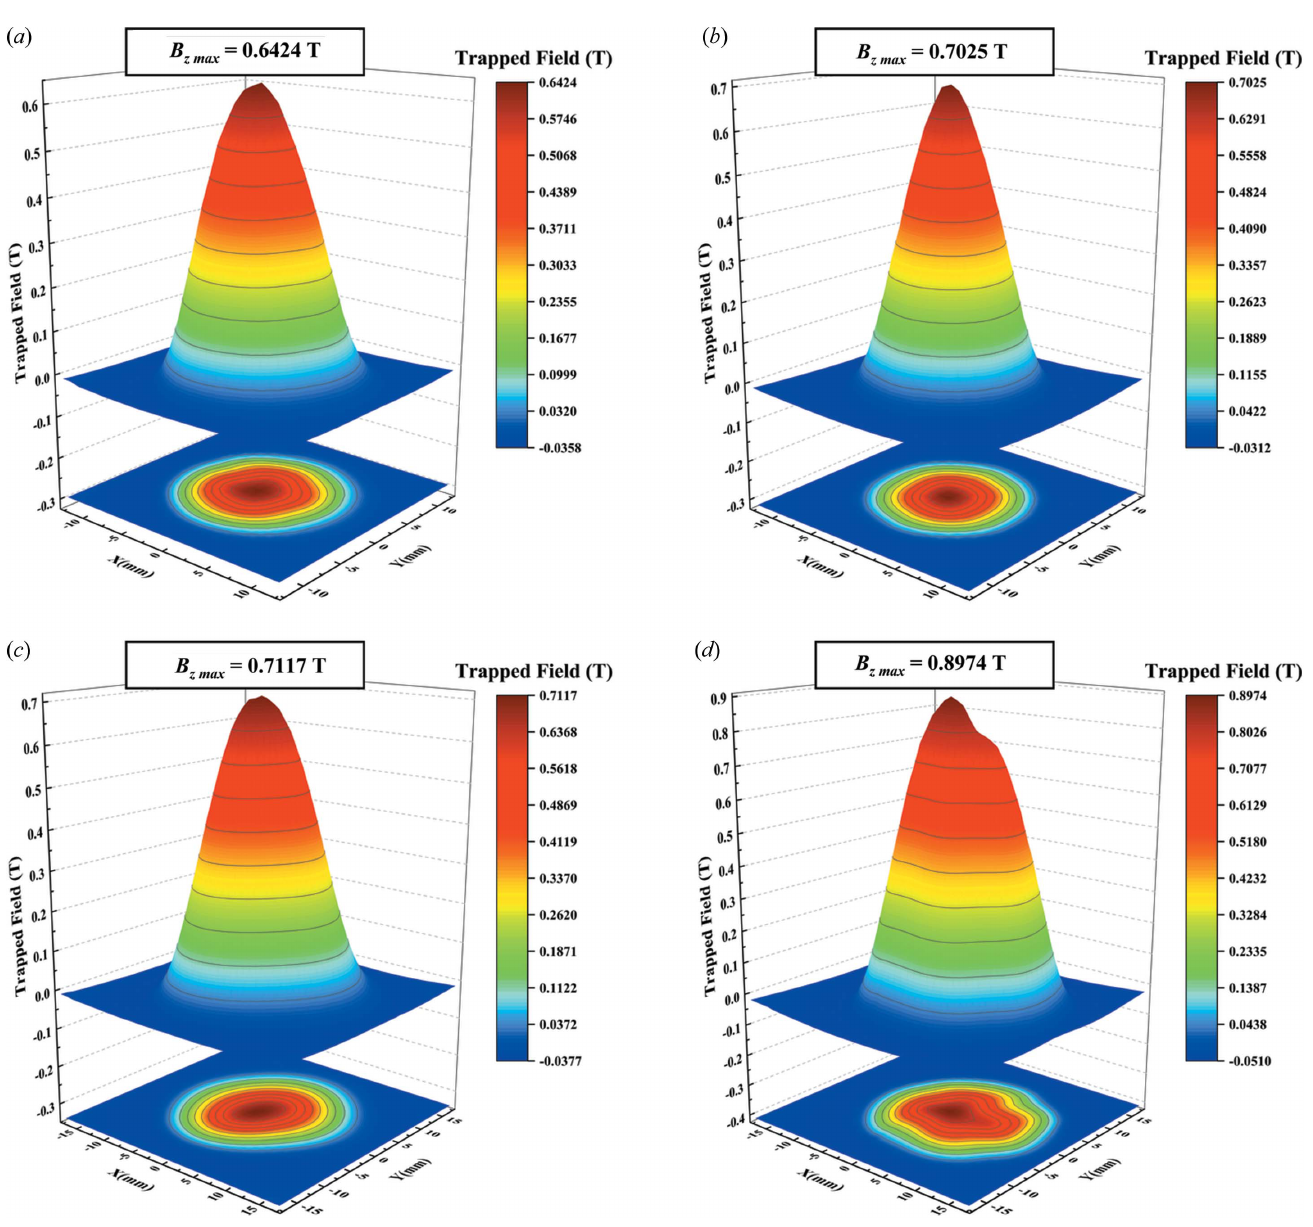
Figure 9 Trapped-field profiles (measured at 77 K) of samples induced by vertically connected seeds: 16 mm-diameter crystals with ( a ) T-type and ( b ) Z-type seeds, 25 mm-diameter crystals with ( c ) L-type and ( d ) T-type